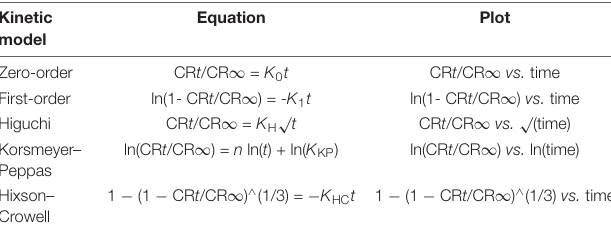
TABLE 3 | Kinetic models used to assess drug release data. Kinetic